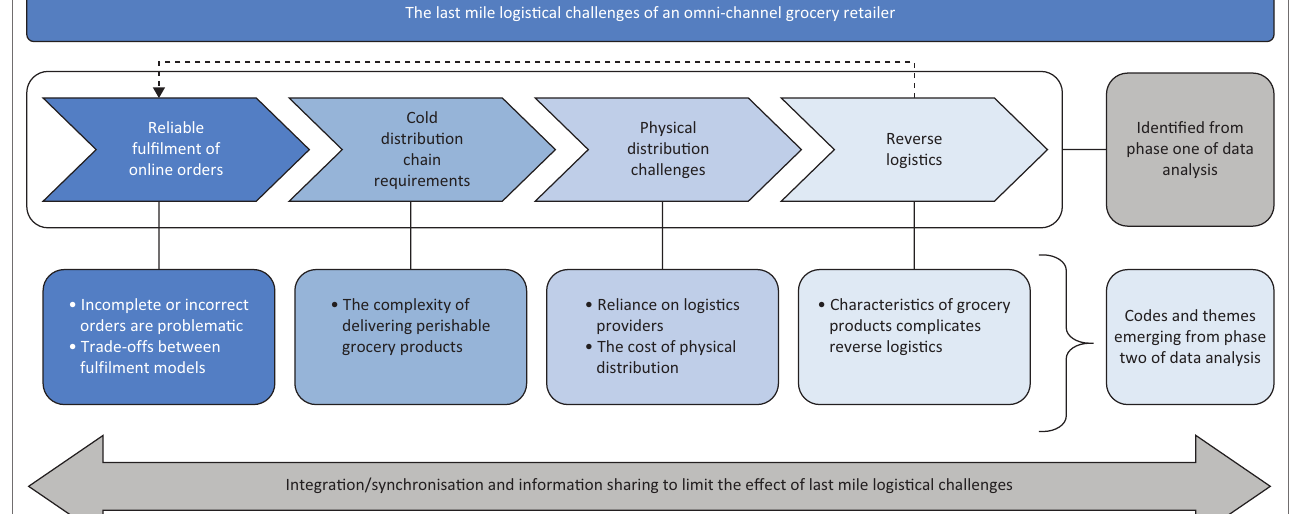
FIGURE 2: The last-mile logistical challenges of an omnichannel grocery